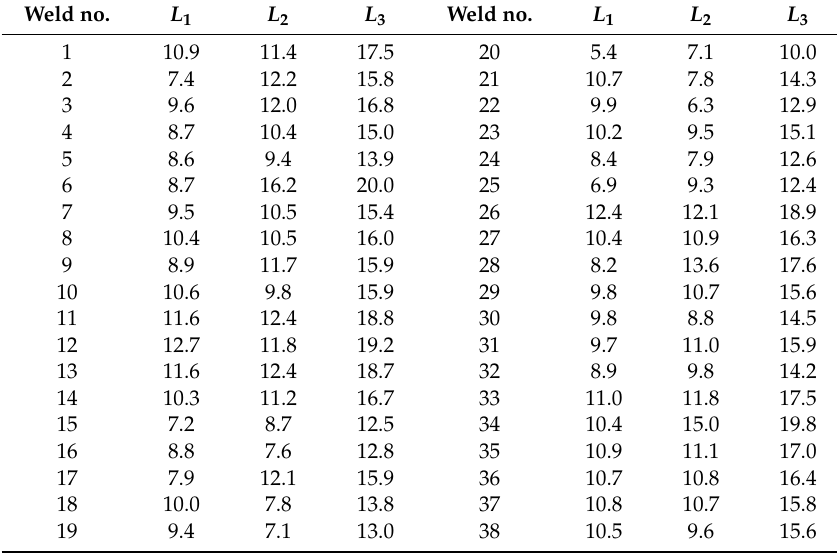
Figure 19. Weld dimension measurement. Table 5. Measured weld size of the experiment components (unit: mm).